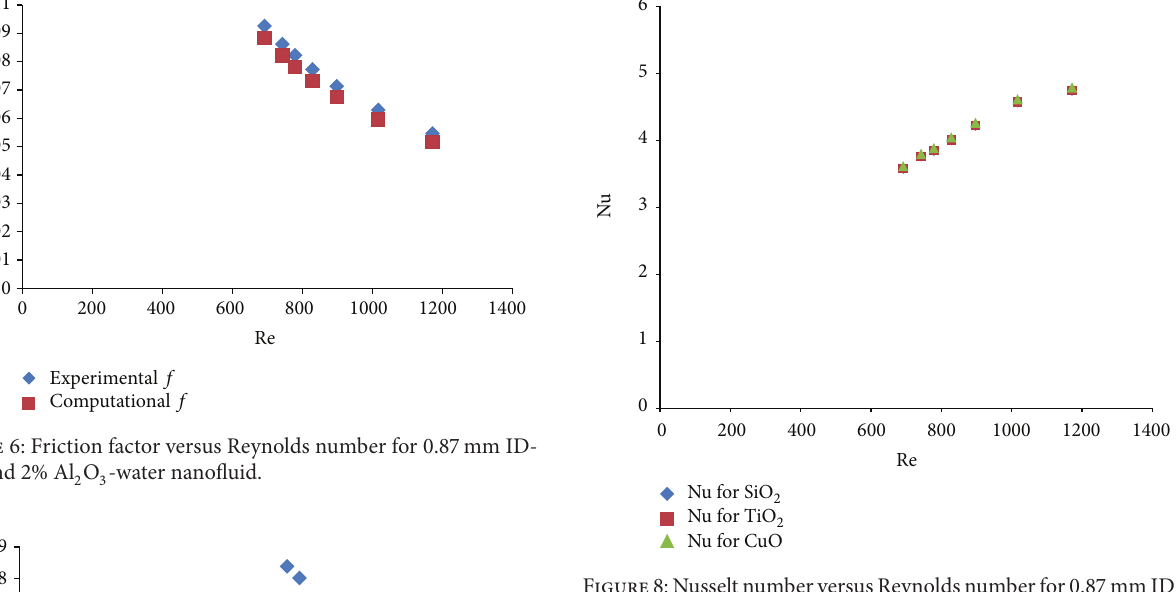
Figure 8: Nusselt number versus Reynolds number for 0.87 mm ID- tube and 2% nanofluid.